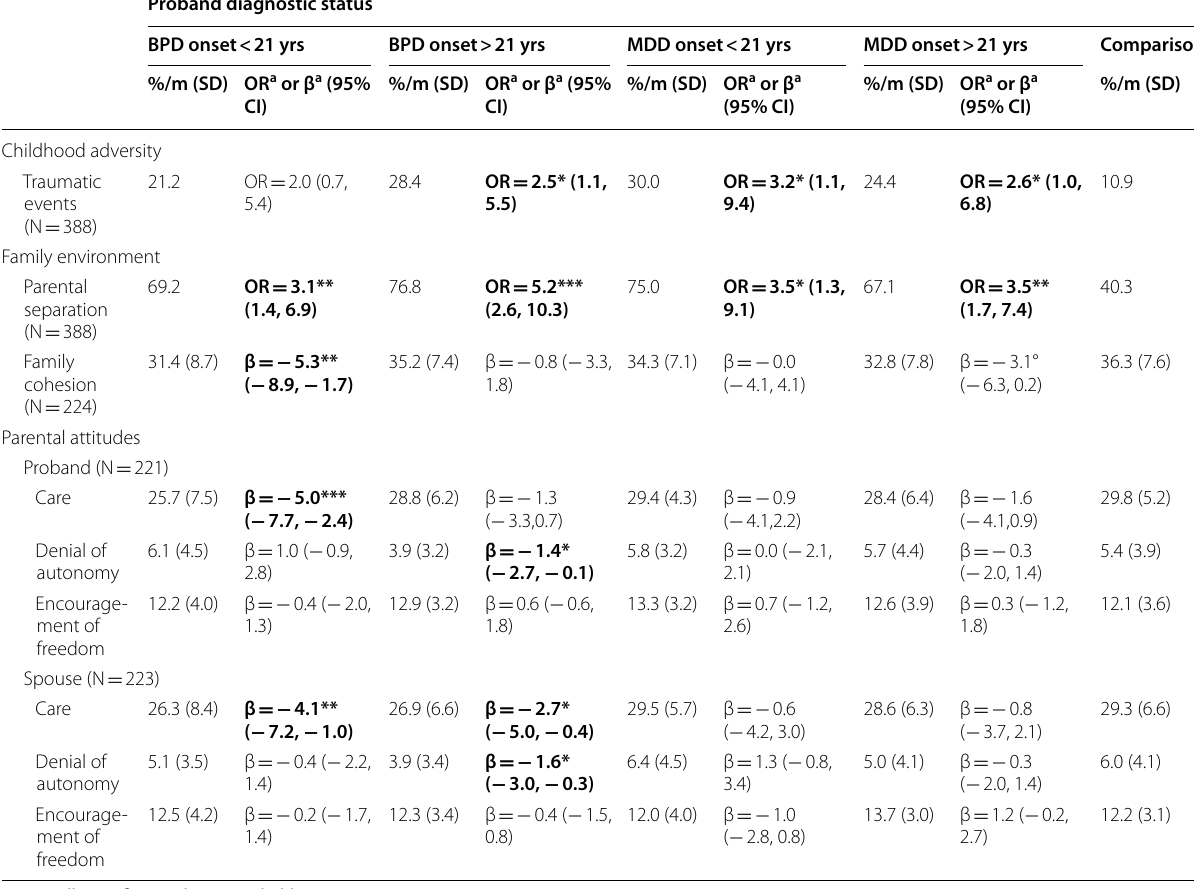
Statistically significant values are in